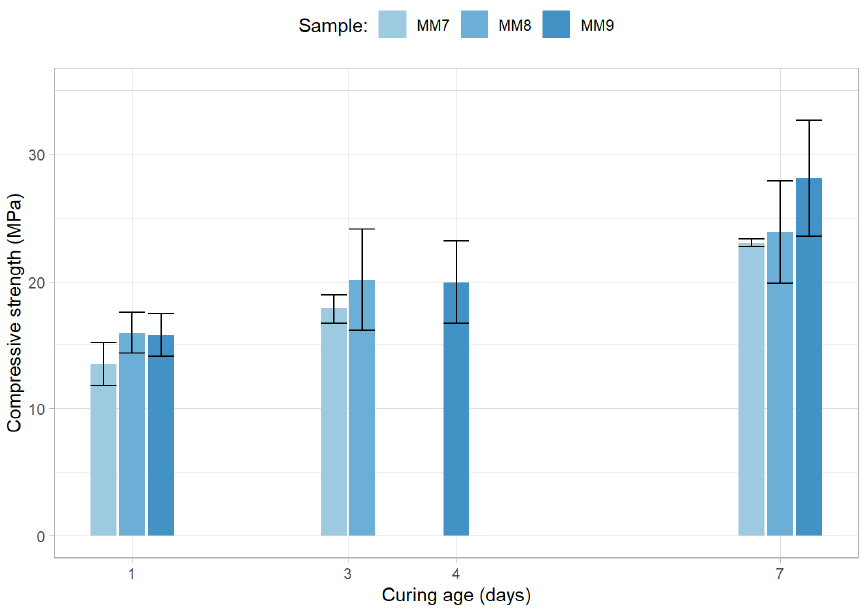
Figure 9. Compressive strength results for the third round of the initial optimization stage.